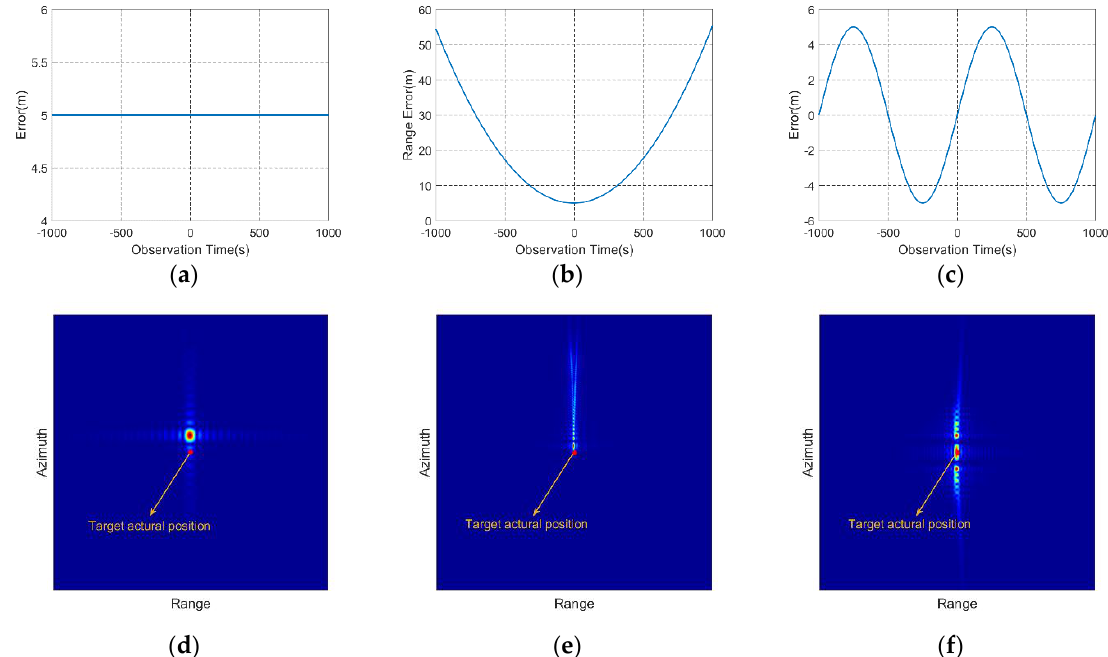
Figure 23. The simulation results of measurement error. ( a ) The constant measurement error in the x -axis direction. ( b ) The quadratic polynomial measurement error in the x -axis direction. ( c ) The sinusoidal measurement error in the x -axis direction. ( d ) The imaging result of the constant error. ( e ) The imaging result of quadratic polynomial error. ( f ) The imaging result of sinusoidal error.